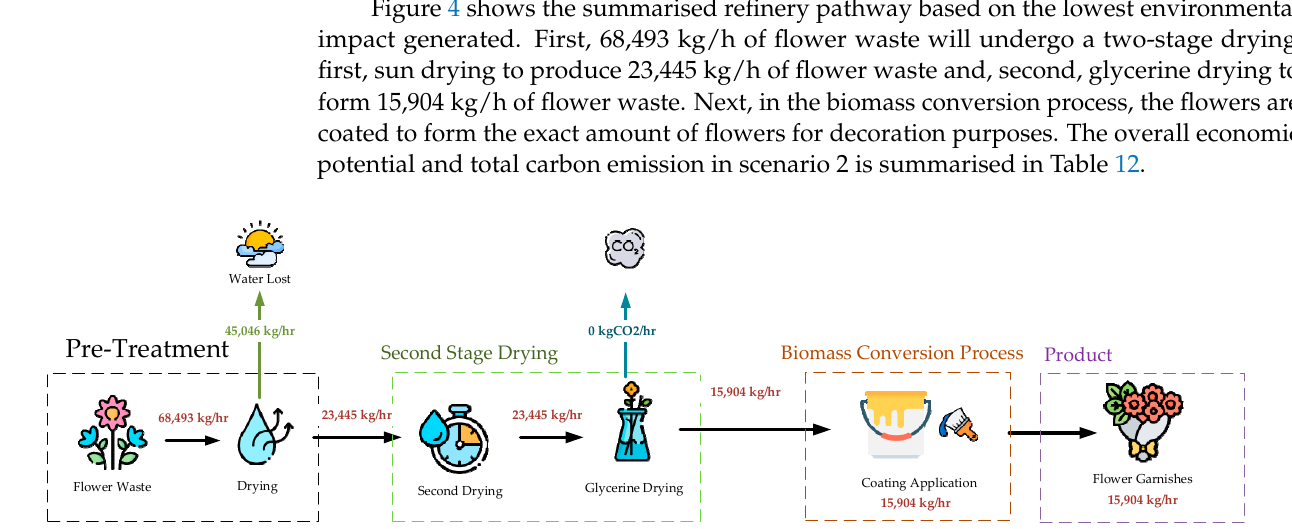
Figure 4. Optimisation based on minimum environmental impact—scenario 2. Table 12. Economic potential and environmental impact in scenario 2.